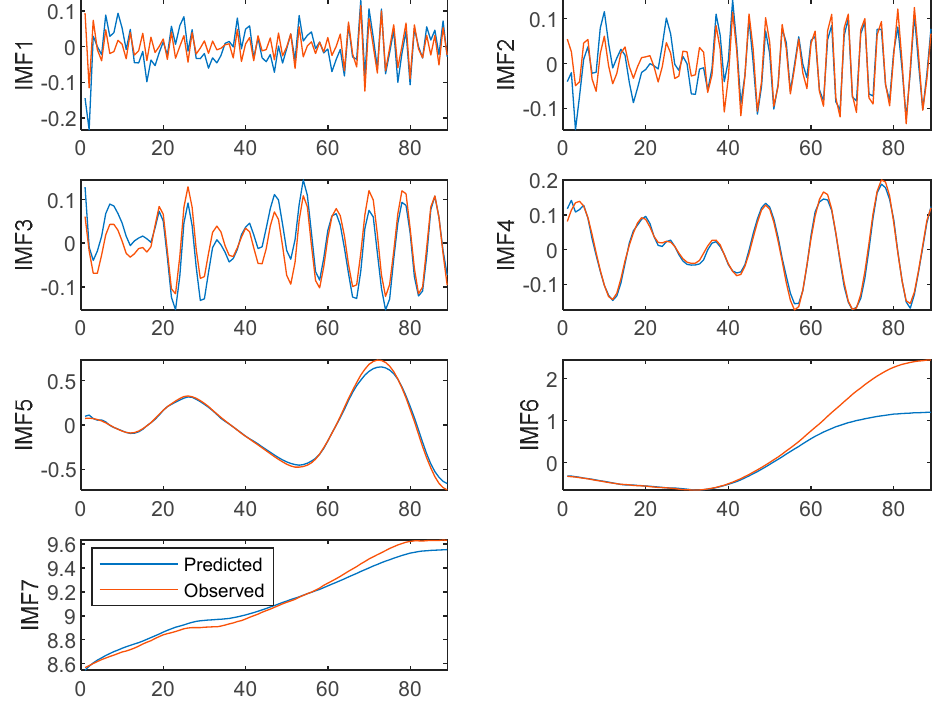
Figure 9. Fitting results for each IMF component of the white chub price dataset.